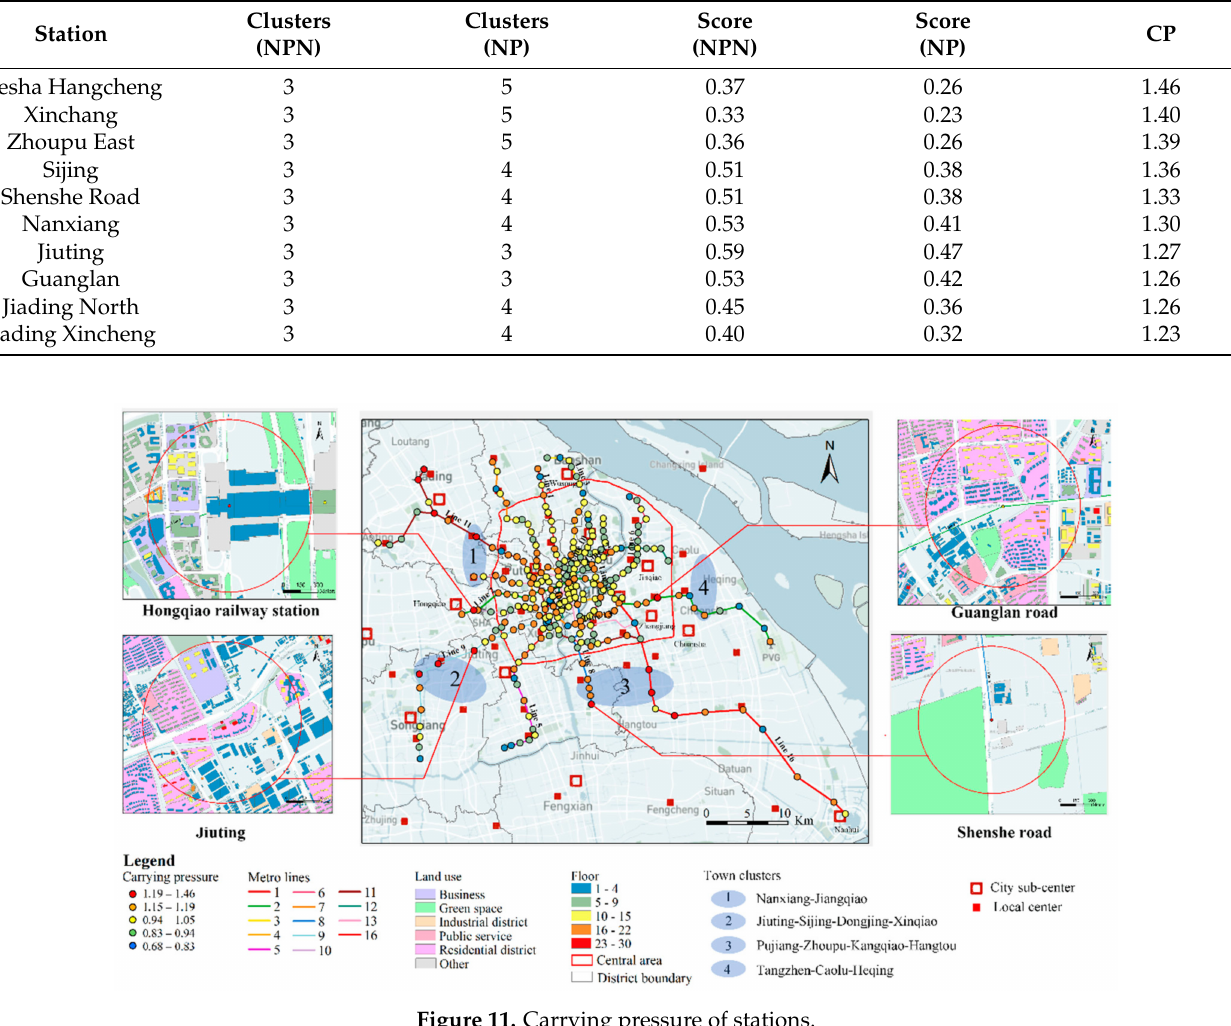
Figure 11. Carrying pressure of